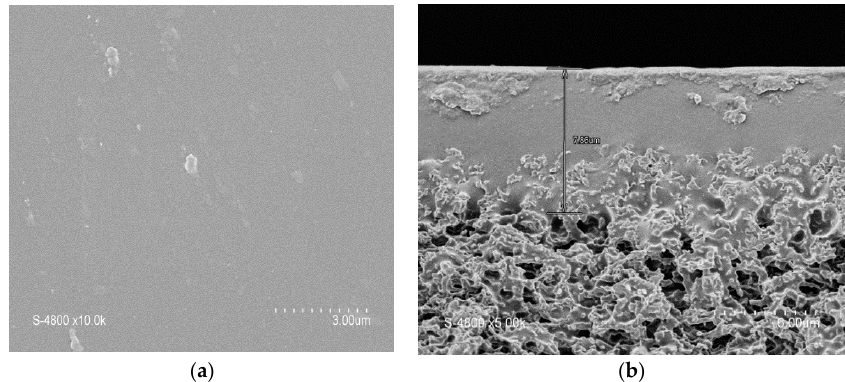
Figure 6. SEM images of the block copolymer porous film casted on the surface of the hydrophobic PVDF membrane after water filtration. ( a ) Top surface. ( b ) Cross section.